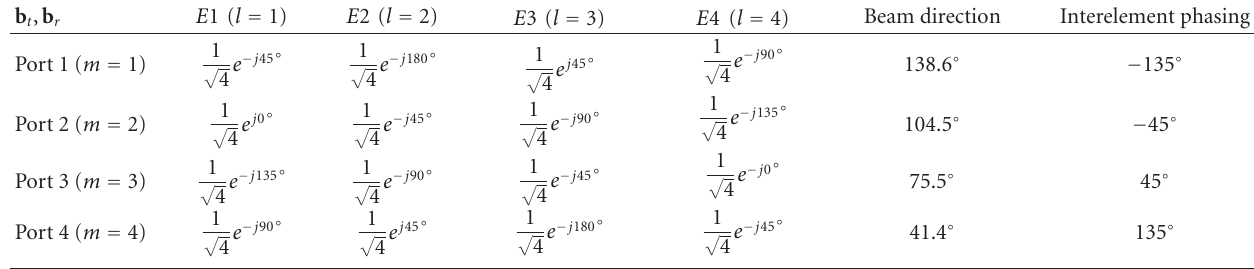
Table 4: Element phasing, beam direction, and interelement phasing for the Butler matrix shown in Figure 3 (conceptual).